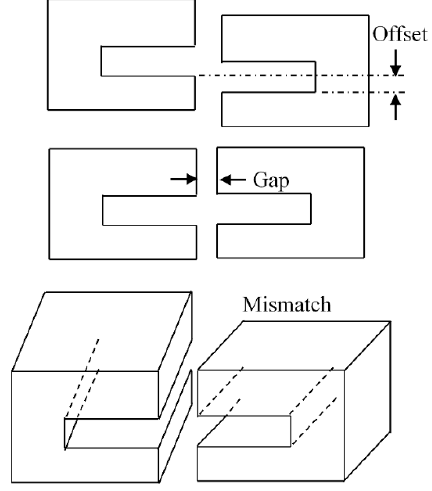
Figure 2. Relative positions of adjacent slots.